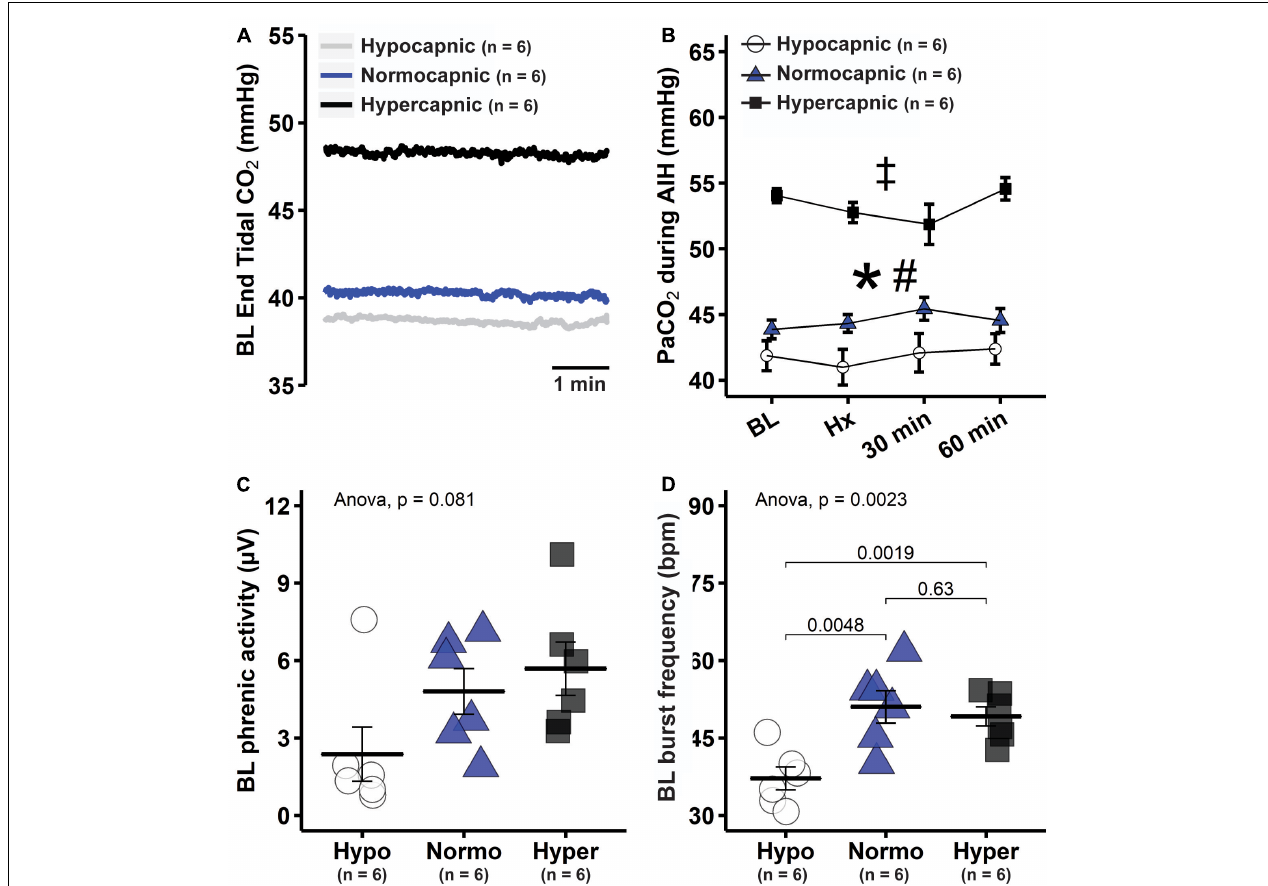
FIGURE 2 | Reduced background PaCO 2 in hypocapnic rats led to lower baseline respiratory activity. (A) Group average end-tidal CO 2 traces during baseline. (B) Average PaCO 2 at specific time points during mAIH protocol in hypocapnic, normocapnic and hypercapnic groups. ANOVA indicated that only group main effect was significant ( p < 0.001); pairwise comparisons of group main effect show that PaCO 2 is lowest in the hypocapnic followed by normocapnic and then the hypercapnic rats. *, significant differences between hypocapnic and normocapnic group; #, significant differences between normocapnic and hypercapnic group; ‡ , significant differences between hypocapnic and hypercapnic group. (C) Group average baseline phrenic burst amplitude. (D) Group average phrenic burst frequency. Data are presented as mean ± standard error of the